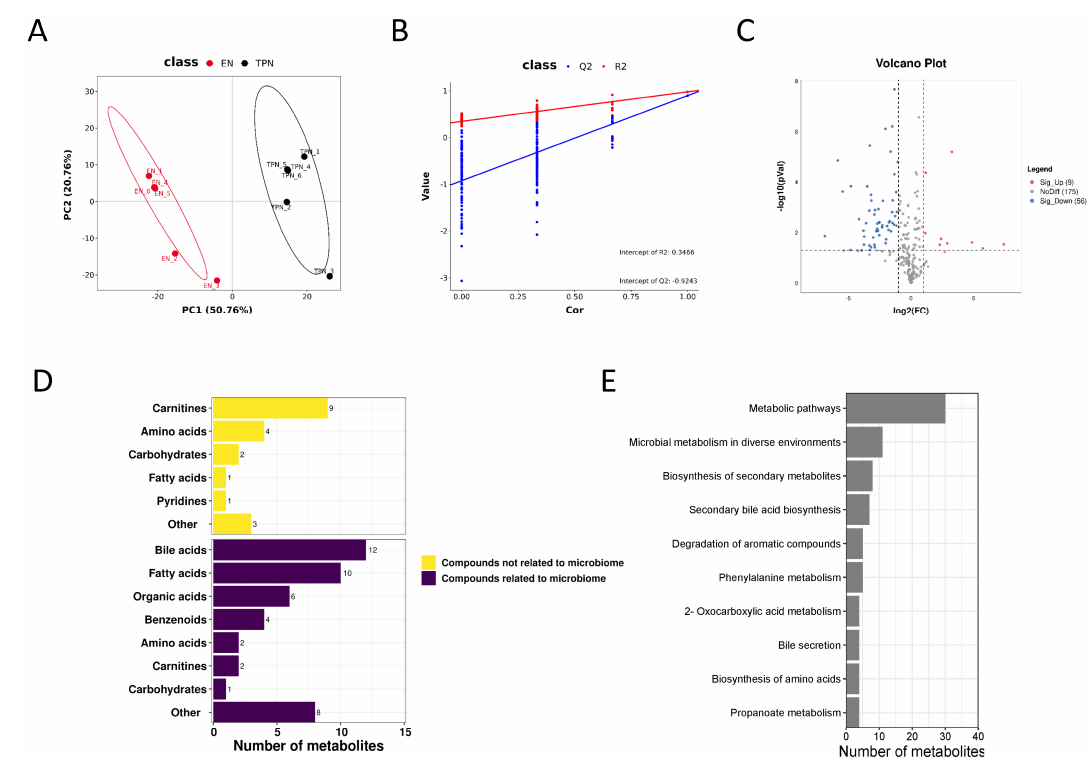
Figure 1. Metabolomic profiles in the ileum epithelium. ( A , B ) Partial Least Squares Discriminant Analysis (PLSDA) and validation plots from the enteral nutrition (EN) and total parenteral nutrition (TPN) piglets. ( C ) Volcano plots showing differential metabolites. ( D ) Classification of identified differential metabolites. ( E ) Kyoto Encylopaedia of Genes and Genomes (KEGG) pathway enrichment analysis of differential metabolites.